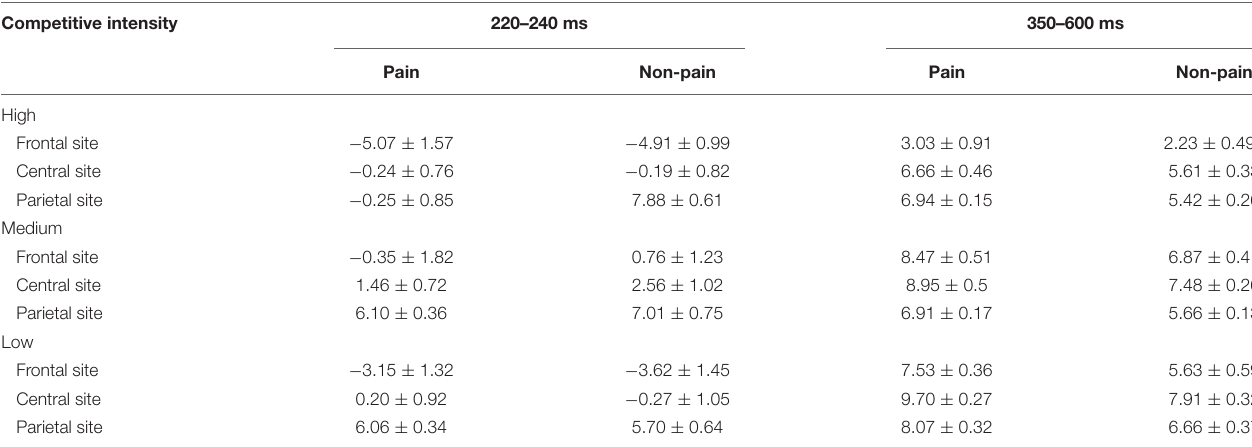
TABLE 3 | Mean amplitudes ( µ V) and standard error at N2 (220–240 ms) and LPP (350–600 ms) shown by the three-way interaction of electrode distribution, stimulus, and competitive